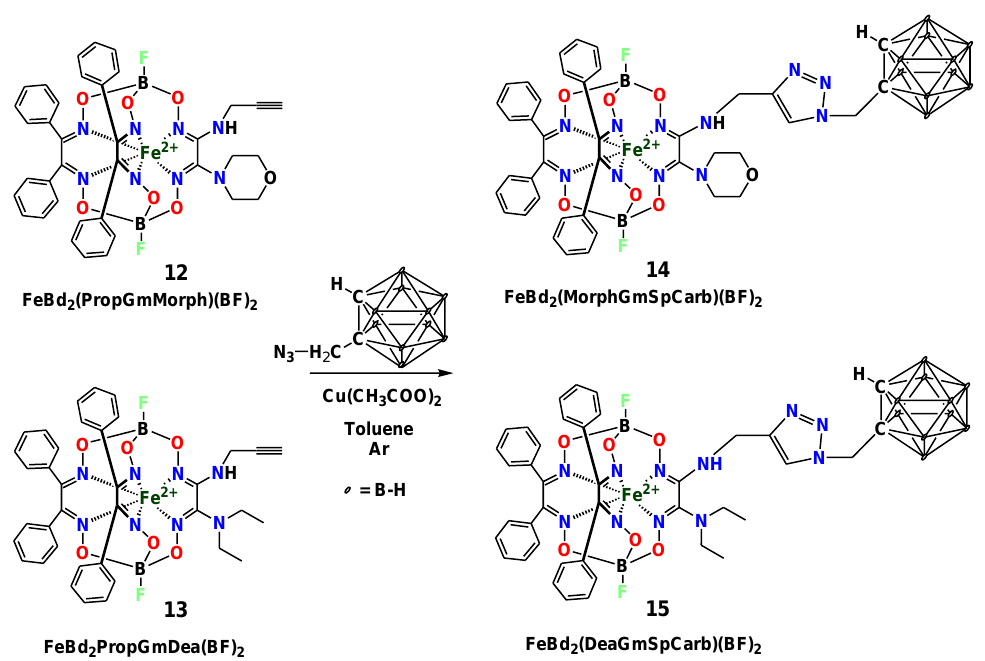
Scheme 4. Synthesis of the morpholine- and diethylamine-functionalized carborano- 1H -[1,2,3]- triazolomethylamine-substituted iron(II) clathrochelates—the hybrid